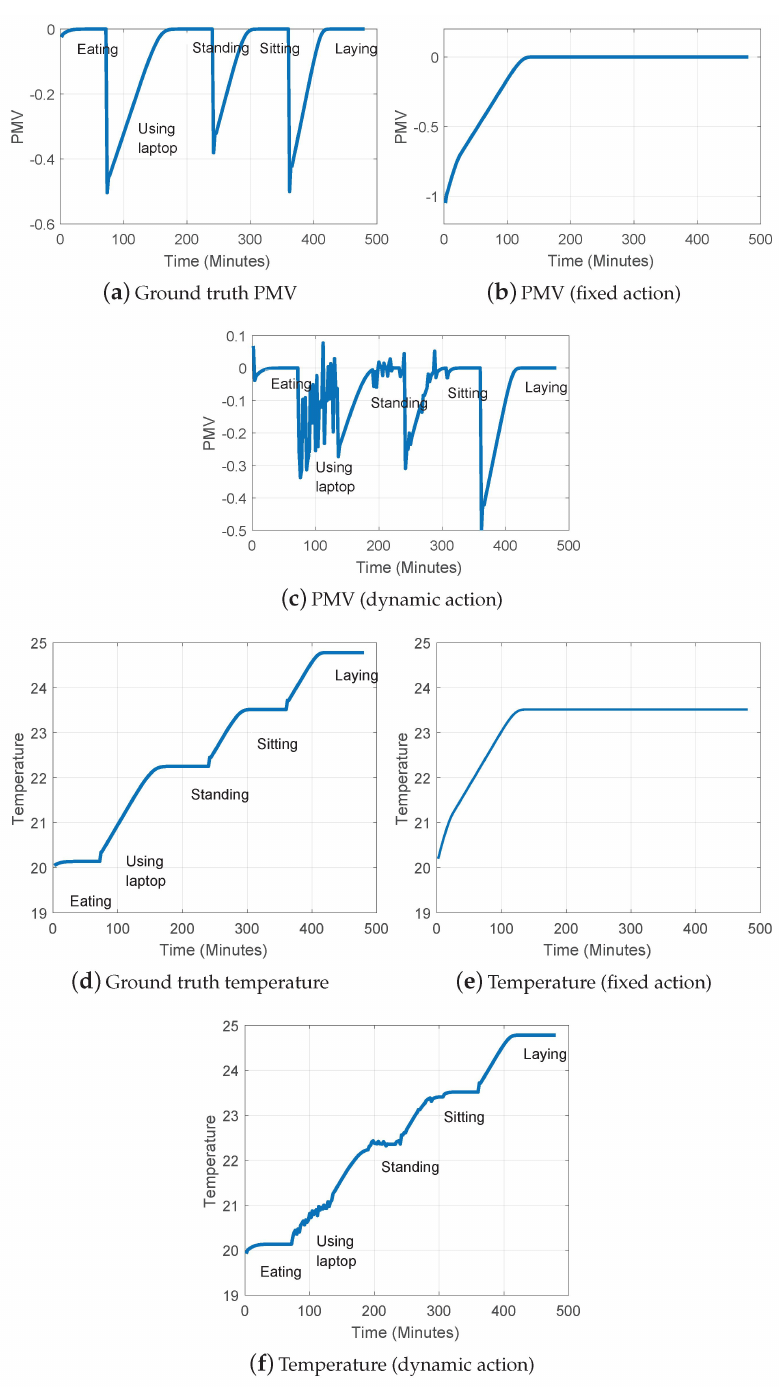
Figure 8. Illustration of ( a ) ground truth PMV values for the set actions over time; ( b ) estimated PMV values using a fixed action assumption; ( c ) estimated PMV values using the action recognition results; ( d ) room temperature, depending on the ground truth PMV values; ( e ) room temperature for the fixed action assumption; and ( f ) room temperature as a result of the automated action recognition estimated PMV